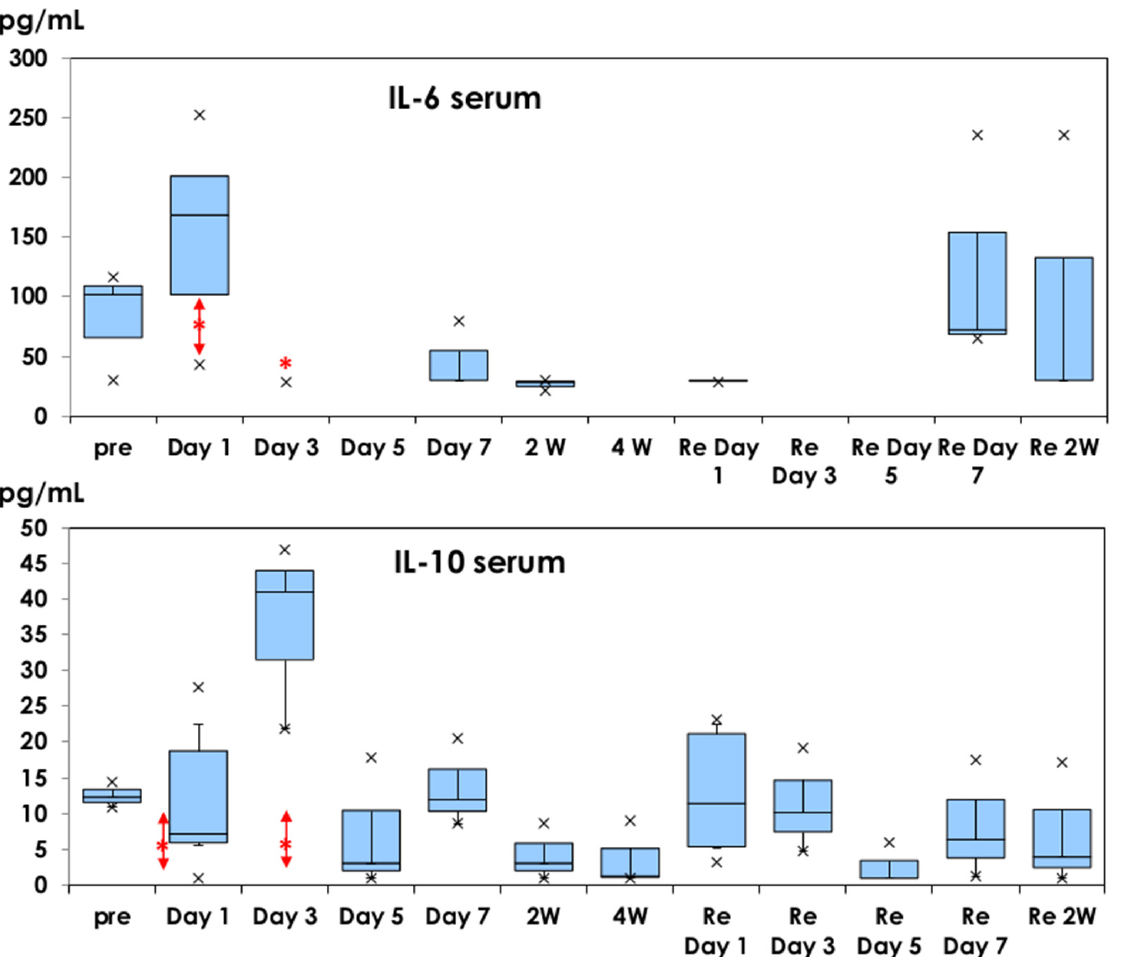
Figure 2. Serum IL-6 and IL-10 profiles. They are shown in box-and-whisker plots with median titers and the range of 5–95%. Samples were obtained before injection, on days 1, 3, 5, and 7, and at 2 and 4 weeks after the first dose. The second dose was administered at 4 weeks and samples were obtained based on the same schedule. *: mean concentration of five mice as a control on day 1 of physiological saline injection. : mean ± 1.0 SD. ×: